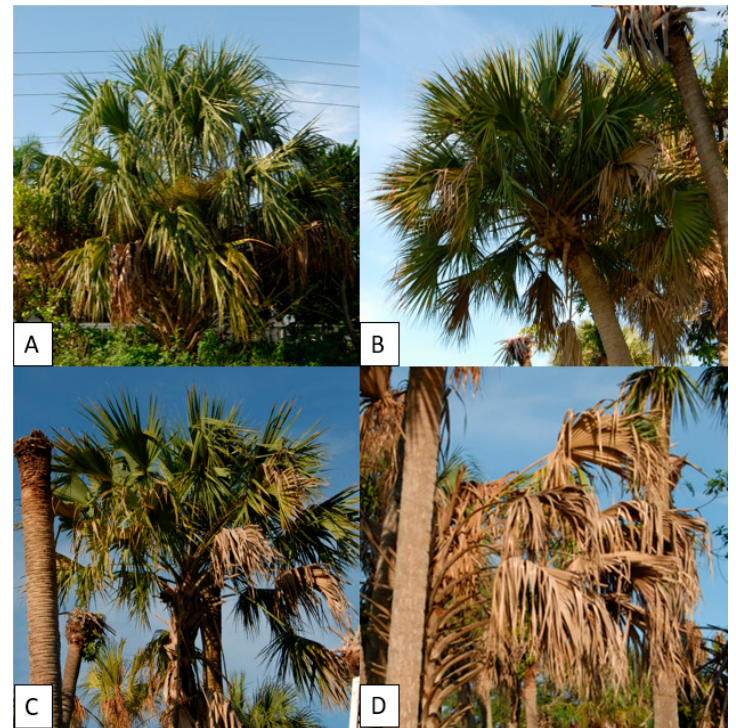
Figure 2. Specimens of Sabal palmetto analyzed for the utility of e-noses for detecting infection by the 16SrIV-D phytoplasma; ( A ) healthy/asymptomatic, ( B ) early symptomatic (ES), ( C ) moderate symptomatic (MS), and ( D ) late symptomatic (LS).